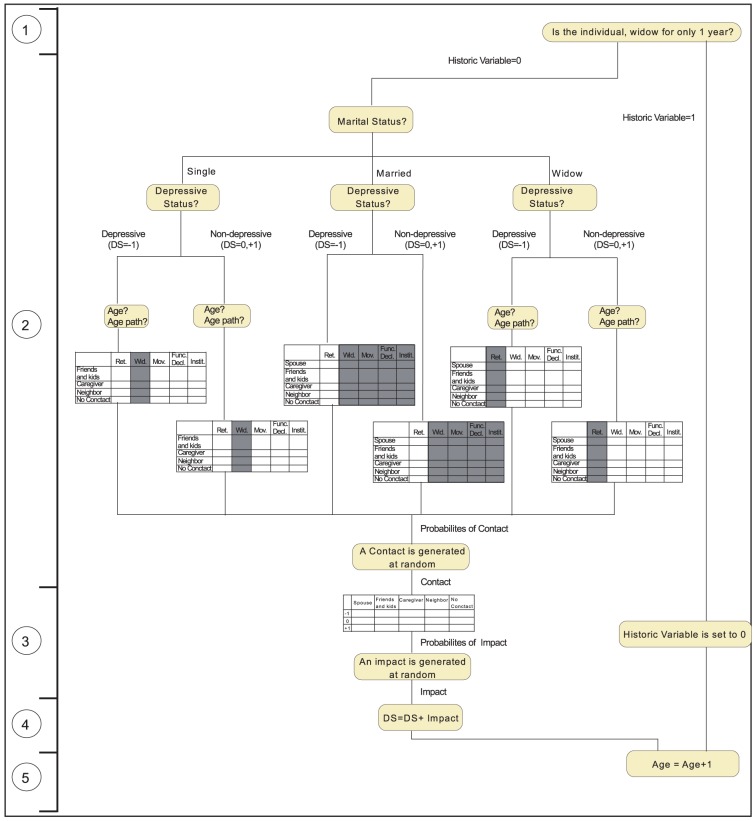
Formal Algorithm at Individual Level.1) The Historic Variable is checked to see if the individual is widow for only one year; if this is the case, the new widow processes directly step 5. 2) Decision tree leading to the random generation of a Contact with one of the actors (grayed columns of the tables are not used. 3) An Impact is generated at random. 4) This impact is added to the current Depressive State 5) The Age is incremented.